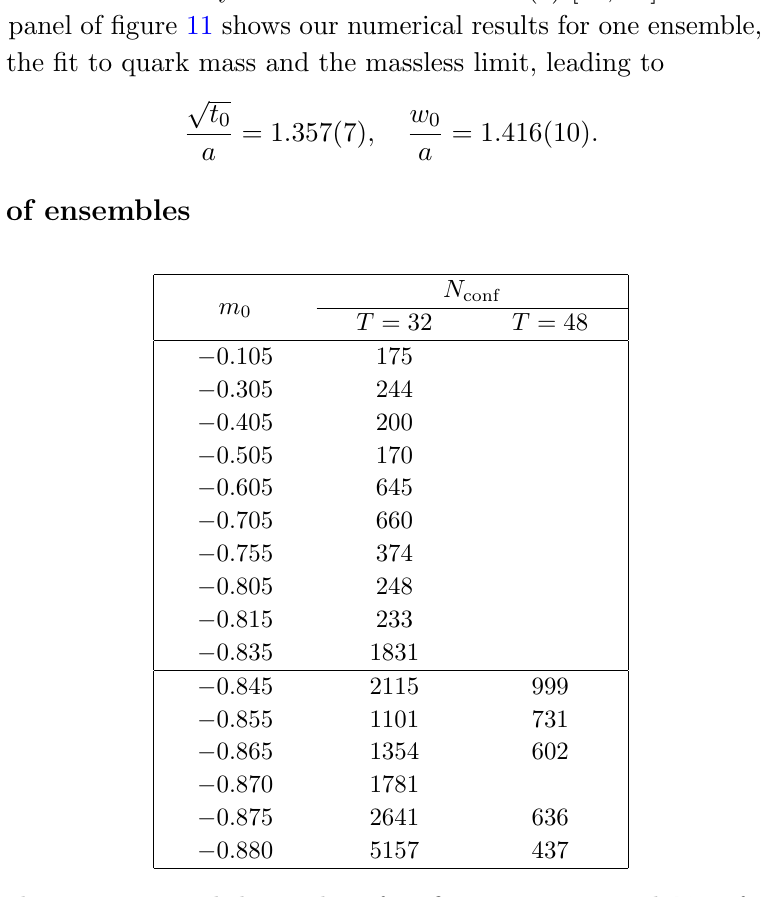
Table 3 . The bare mass m 0 and the number of con(cid:12)gurations generated N conf for the ensembles used in this